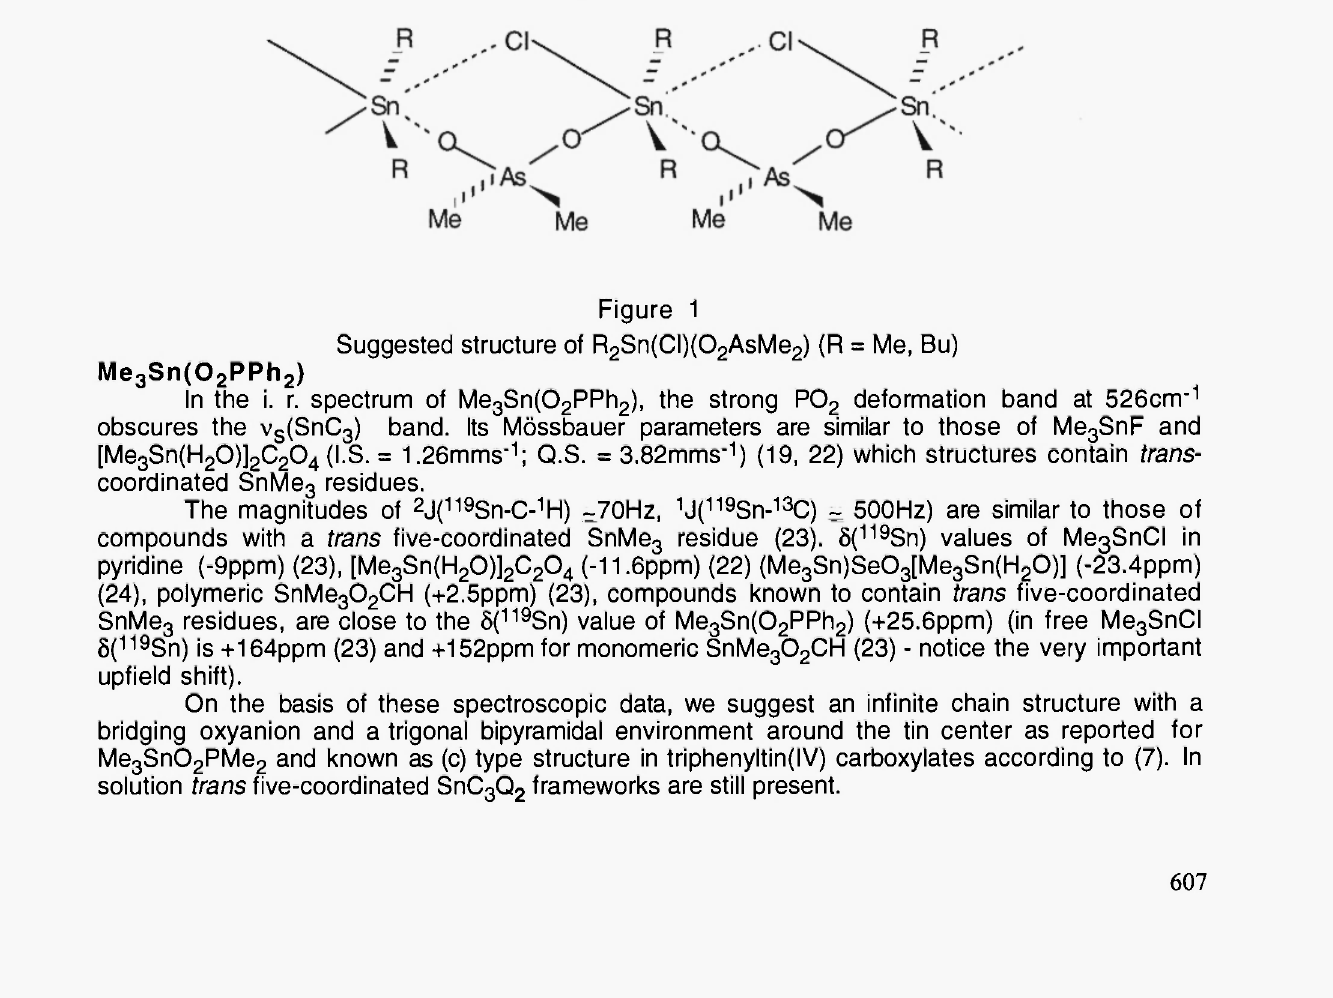
Suggested structure of R